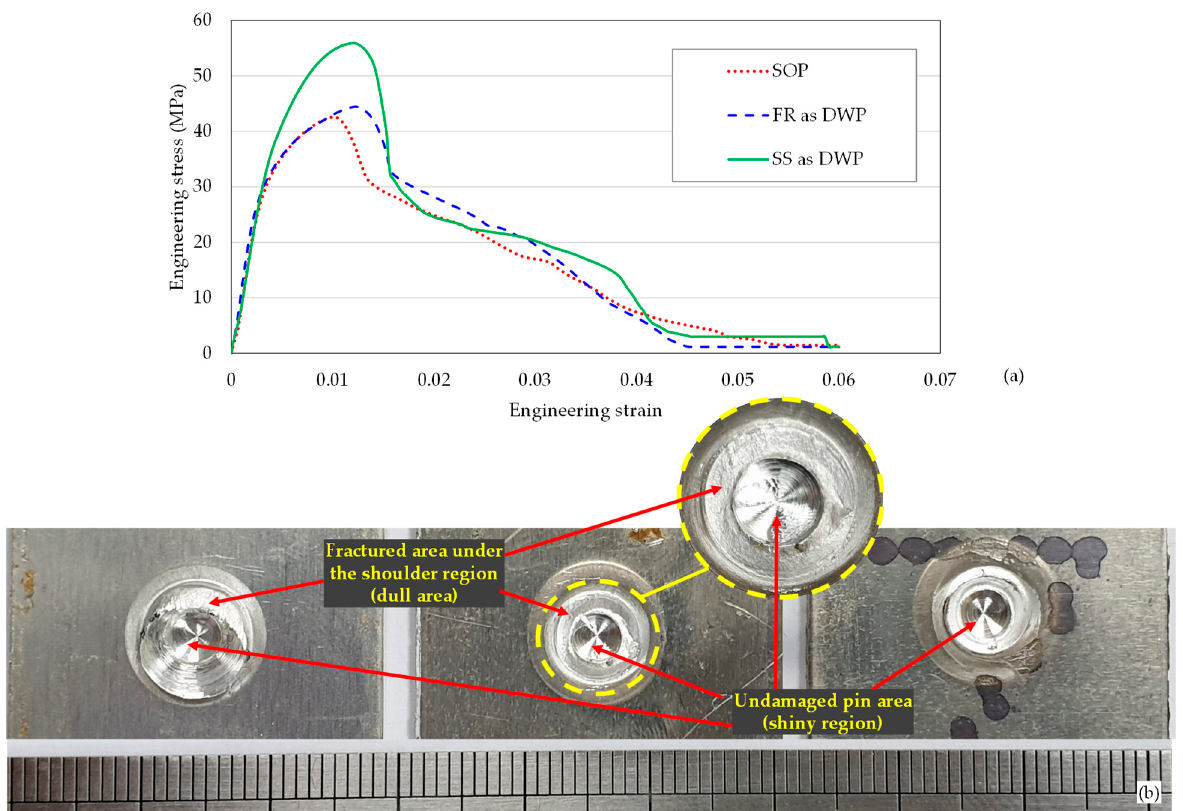
Figure 15. ( a ) Comparison of the stress–strain curves under different welding conditions. ( b ) Typical examples of the welds’ fractured areas.